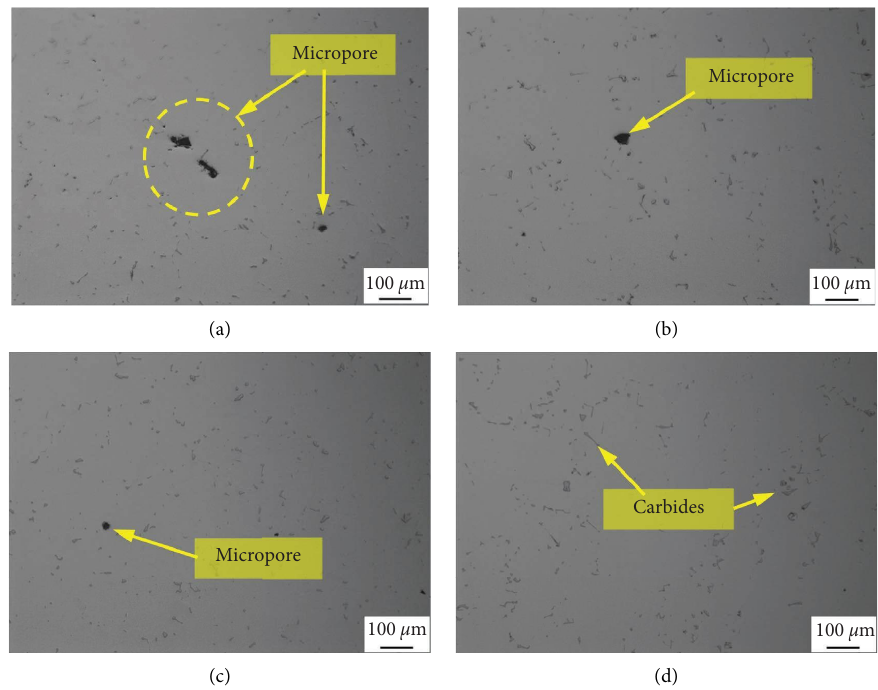
Figure 3: Images of micropore and carbide morphology of K417G in as-cast (a), HIP1170 (b), HIP1185 (c), and HIP1195 (d). 0.00.10.20.30.40.5